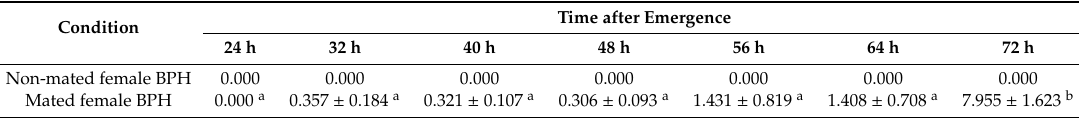
Table 3. Identification of Pichia guilliermondii in the chest hemolymph of non-mated and mated BPH